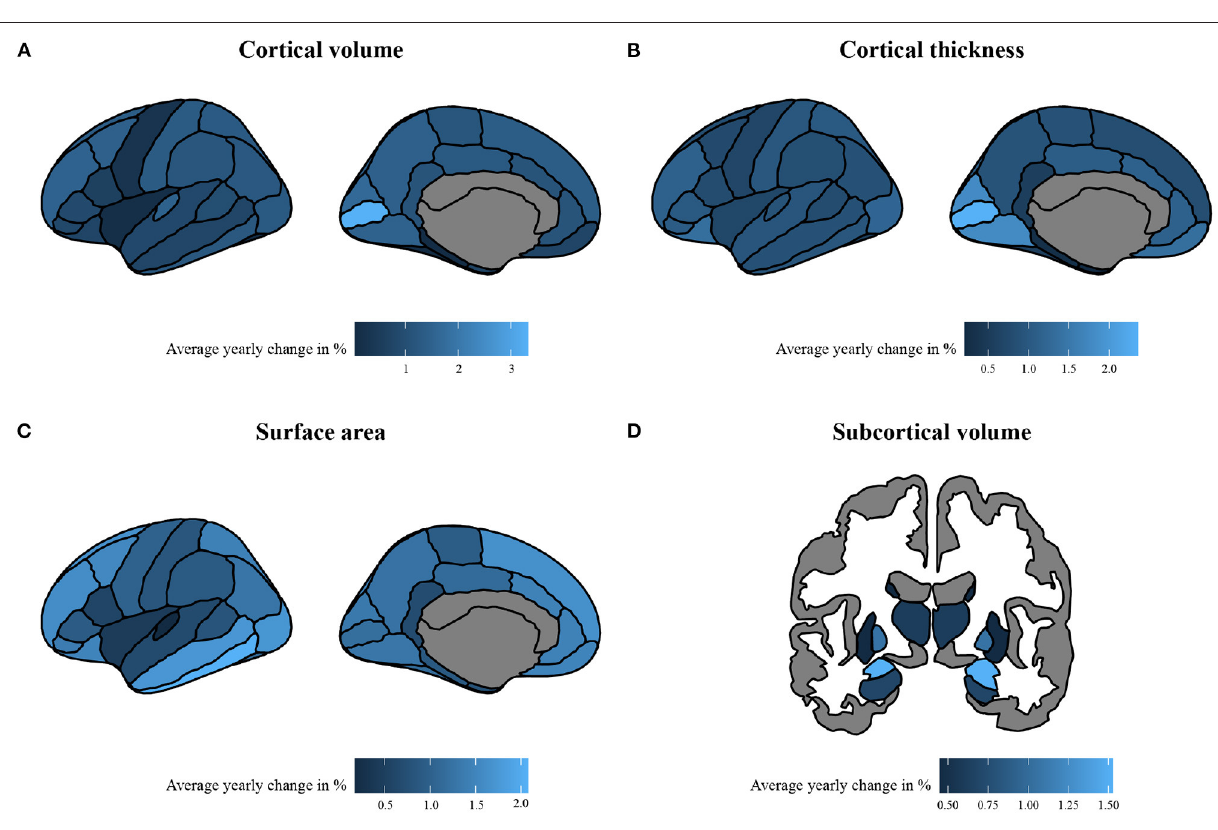
FIGURE 4 | The absolute average percentage change per year of morphological measures. The change is calculated with absolute percentages of change per year, calculated across a span of 6–16 years in (A) cortical volume, (B) cortical thickness, (C) surface area, and (D) subcortical volume. To enhance interpretability, absolute average change was calculated using brain measures that were rescaled to their original means and standard